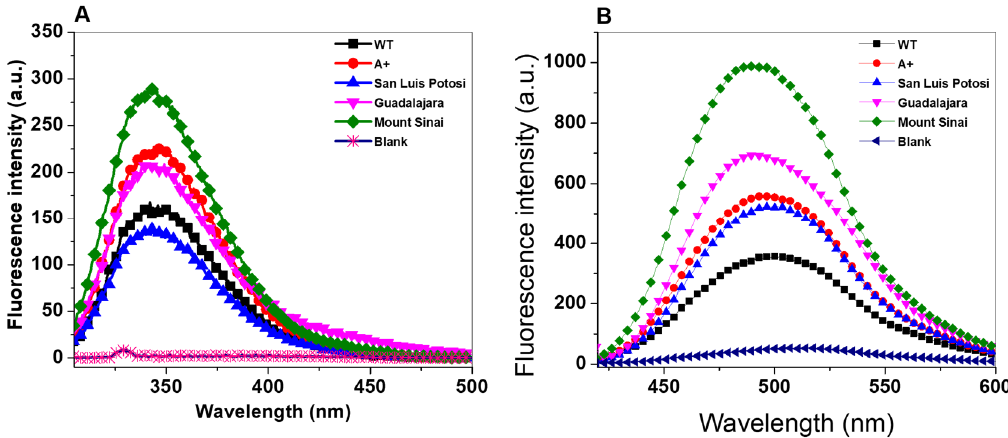
Figure 7. Fluorescence emission spectra of WT G6PD and variants. ( A ) Intrinsic fluorescence spectra and ( B ) 8-anilinonaphthalene-1-sulphonate (ANS) assays of WT G6PD and variants. Experimental conditions for all experiments are described in Materials and